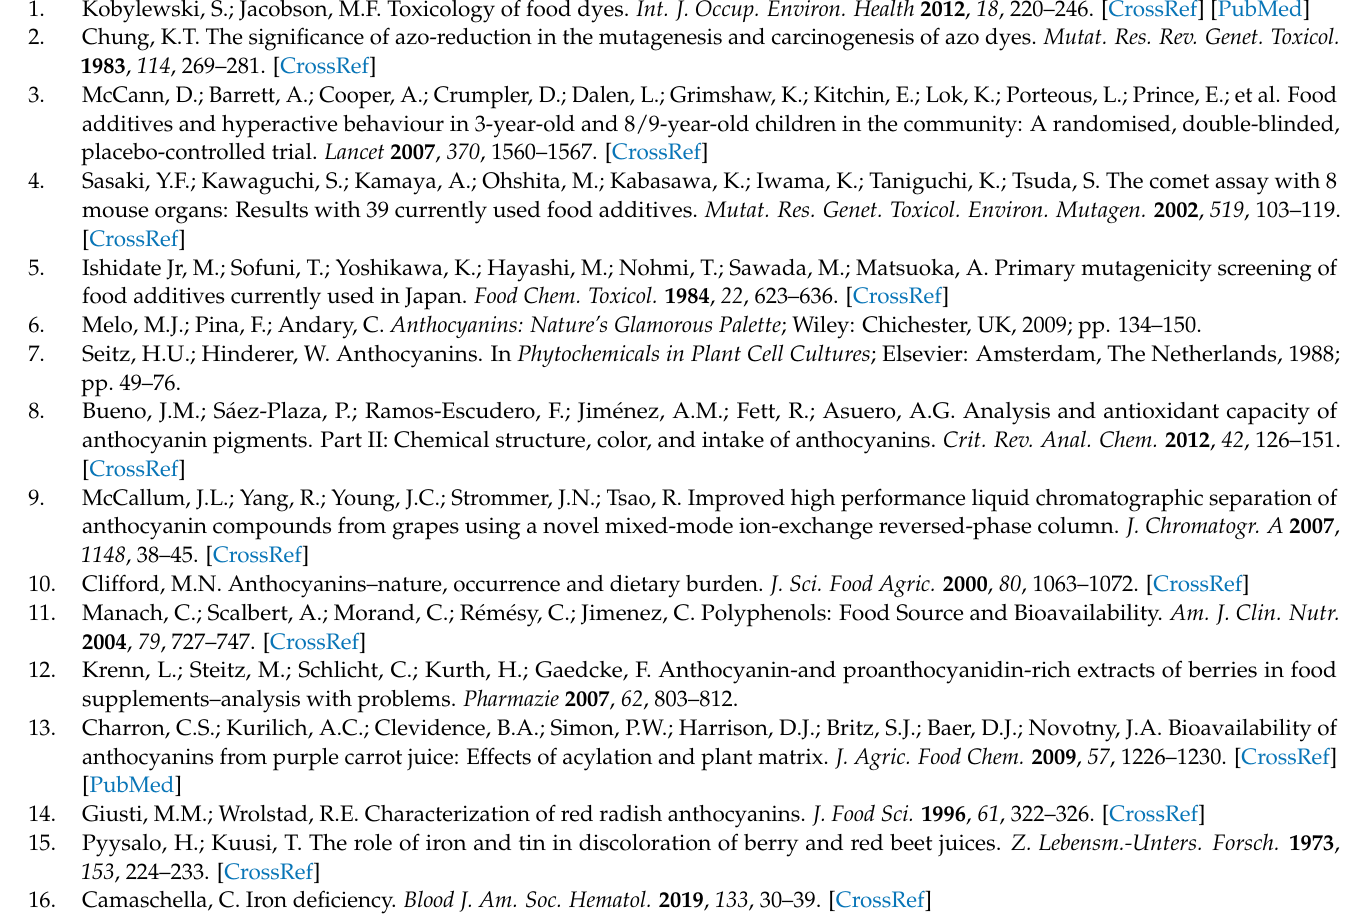
Figure S3: Nanoparticle size distribution analysis based on SEM images; Figure S4: Stacked spectra of each blank silver nanoparticles (Averaged, Common scale); Figure S5: Stacked spectra of each silver nanoparticle incubated with purple carrot extract. (Averaged, Full scale, light-colored spectra represent their silver background signal); Figure S6: Principal component spectra of anthocyanin extracts; Figure S7: Actual vs. prediction PLS plot in external validation for each stabilization index; Table S1: Average diameter of silver nanoparticles by dynamic light scattering (DLS)